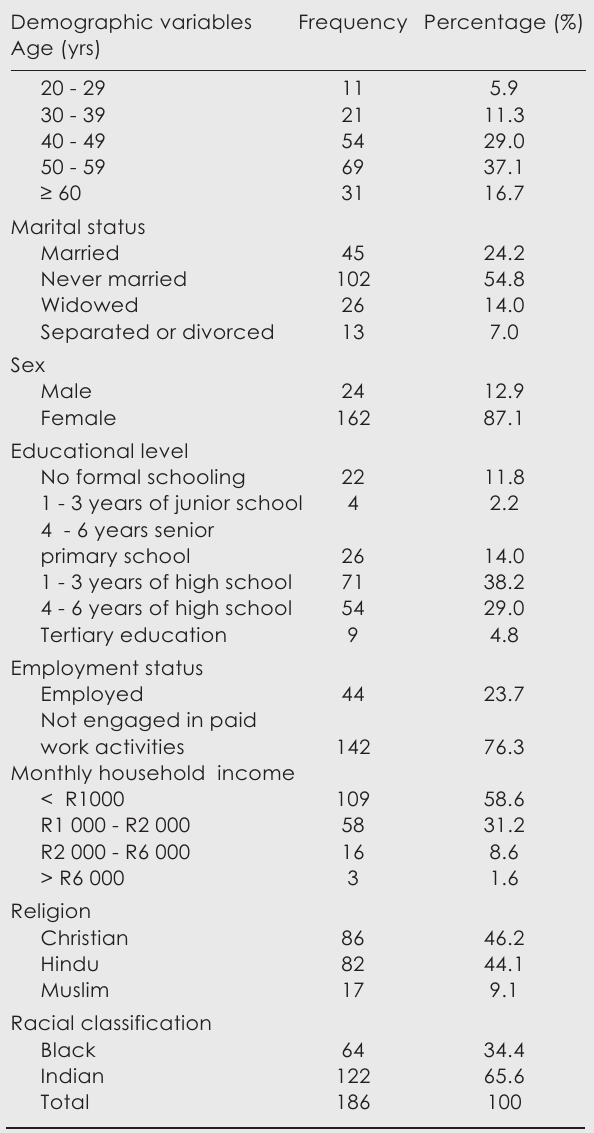
Table I. Frequencies and percentages of the